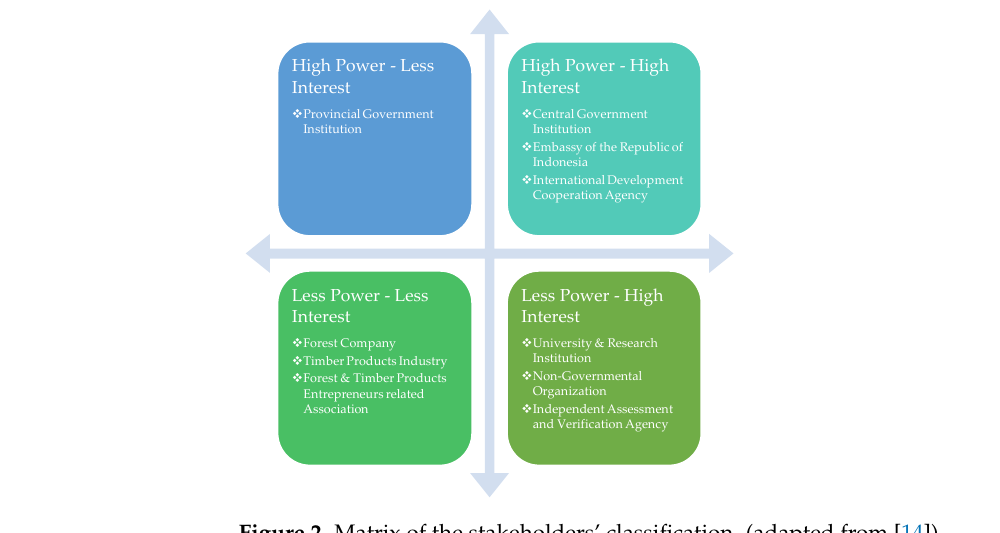
Figure 2. Matrix of the stakeholders’ classification. (adapted from [14].) Table 1. Categorization of stakeholders for survey and